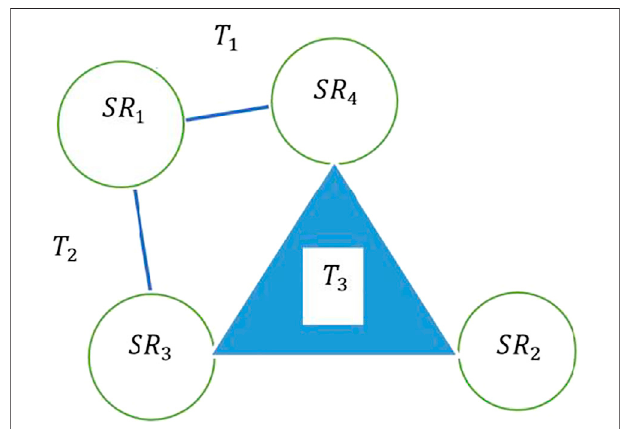
FIGURE 1 | A representation of task collaboration among sensors of a robot using simplicial complexes.